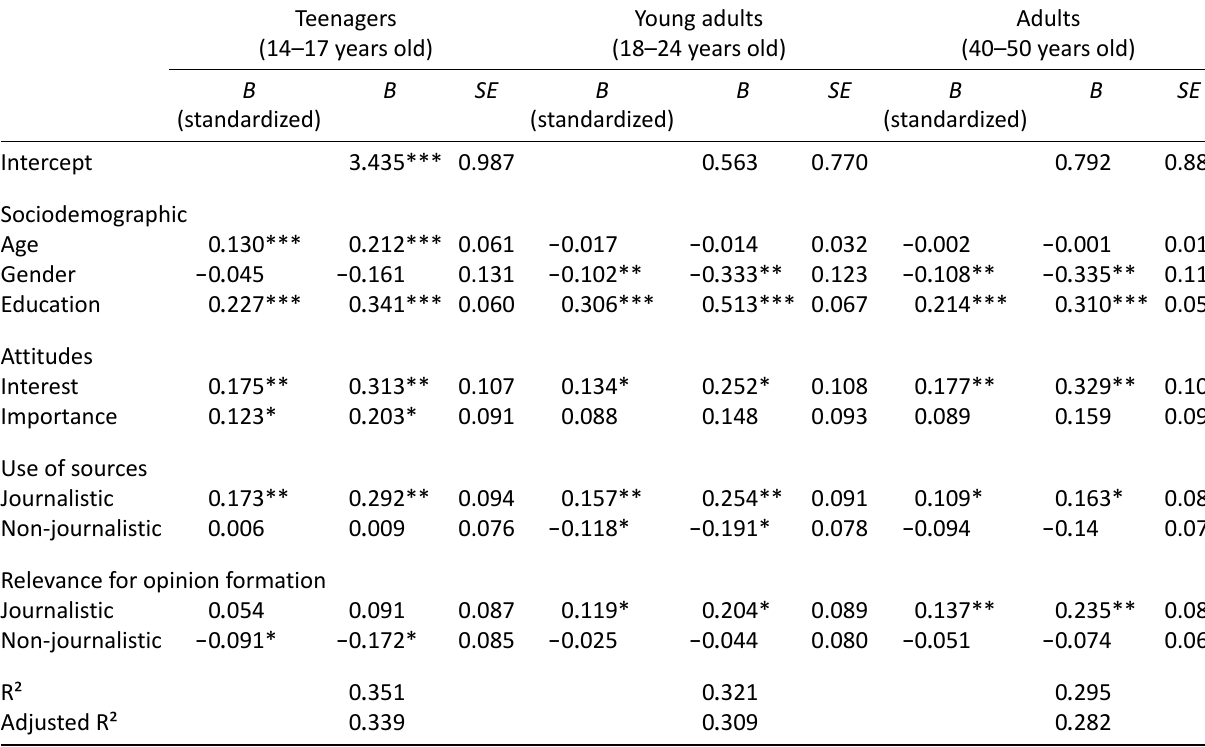
Table 3. Regression analysis of the factors influencing news audiences’ degrees of